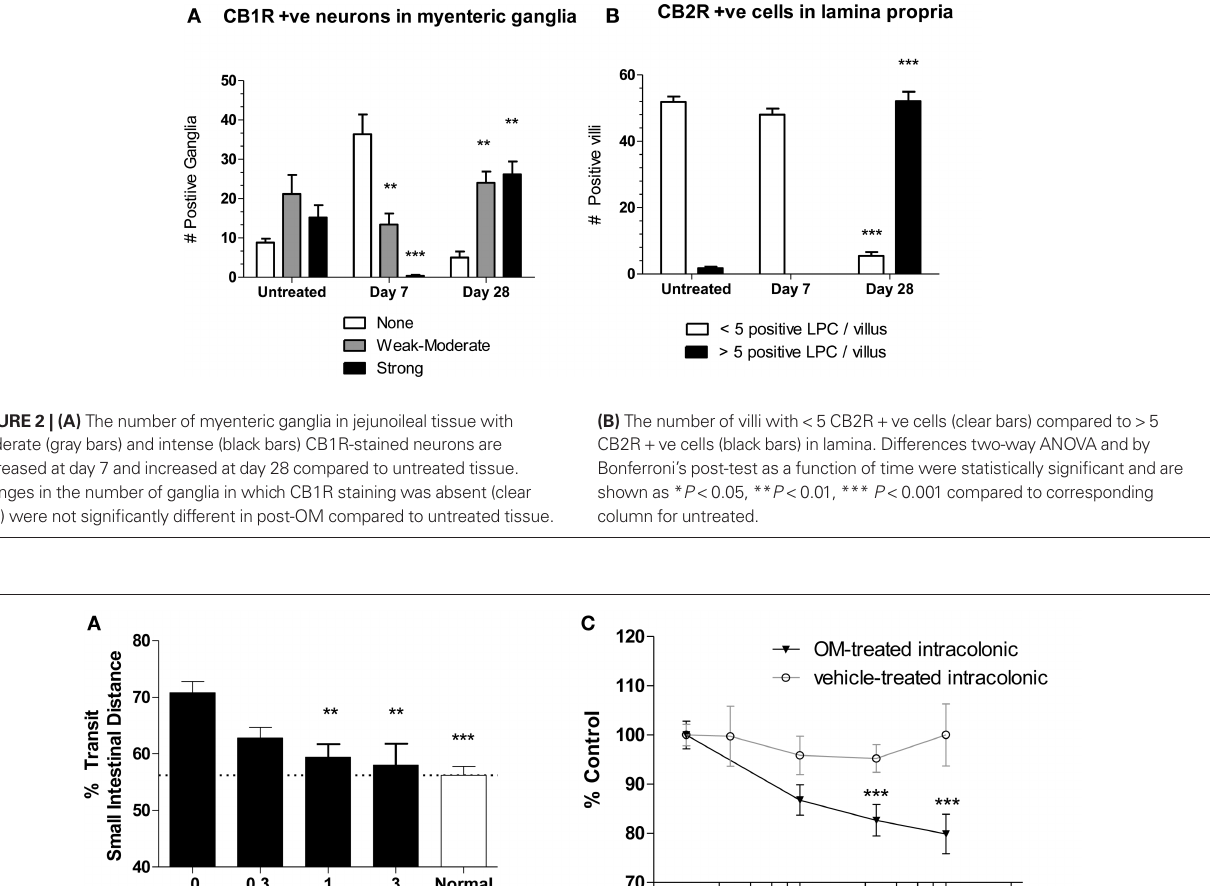
(B) The number of villi with < 5 CB2R + ve cells (clear bars) compared to > 5 CB2R + ve cells (black bars) in lamina. Differences two-way ANOVA and by Bonferroni’s post-test as a function of time were statistically significant and are shown as * P < 0.05, ** P < 0.01, *** P < 0.001 compared to corresponding column for untreated.